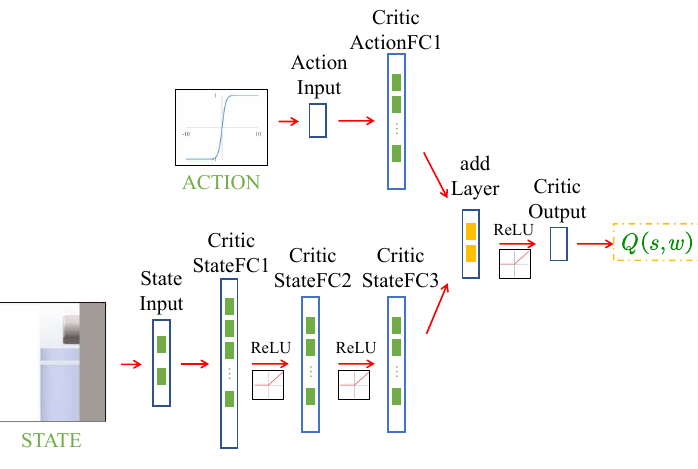
Figure 4. The diagram of Q network. The parameters of each layer in the Q network are shown in Table 2. Table 2. Q network